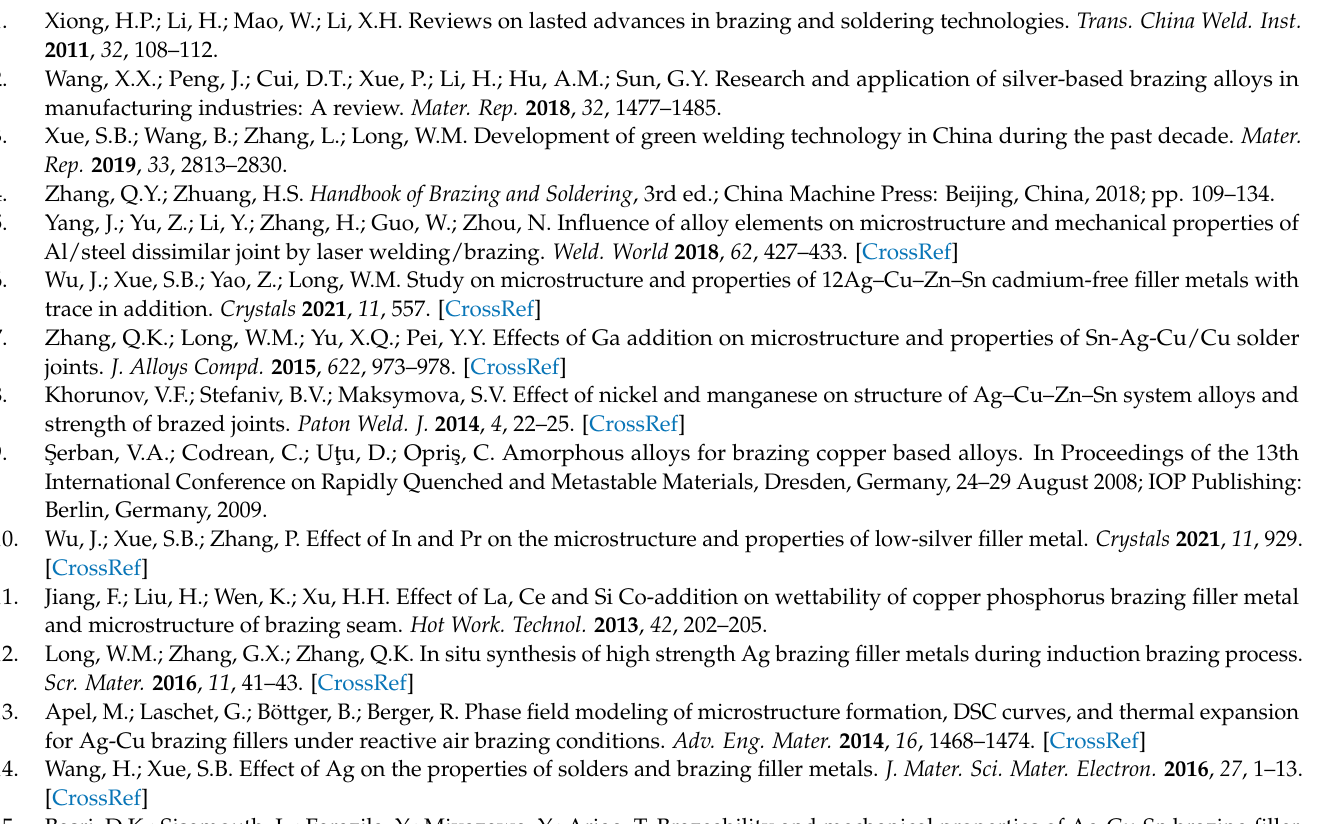
Full-scene application aspect: the service environment of brazing filler metals is usually complex, and will face a multiple-field coupling effect in practical applications. Sn-containing filler metals under the multifield coupling